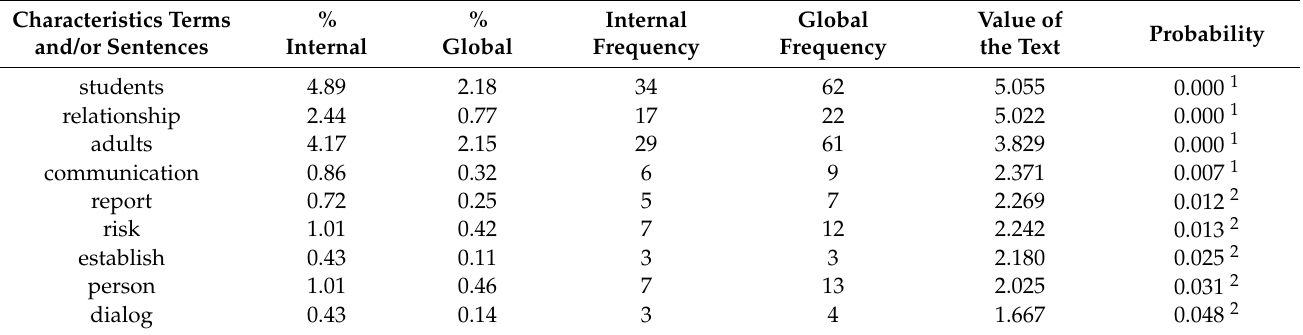
Table 5. Parents’ answers to the question “How the family might prevent school